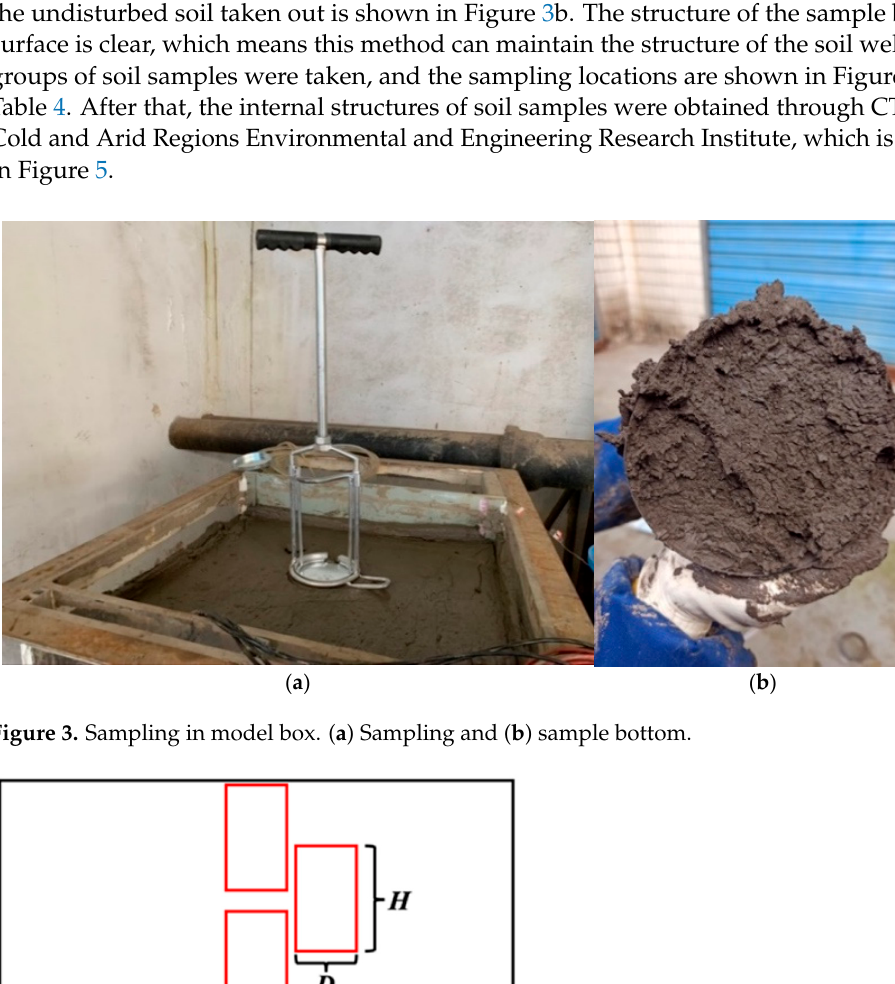
Table 4. Sampling location.